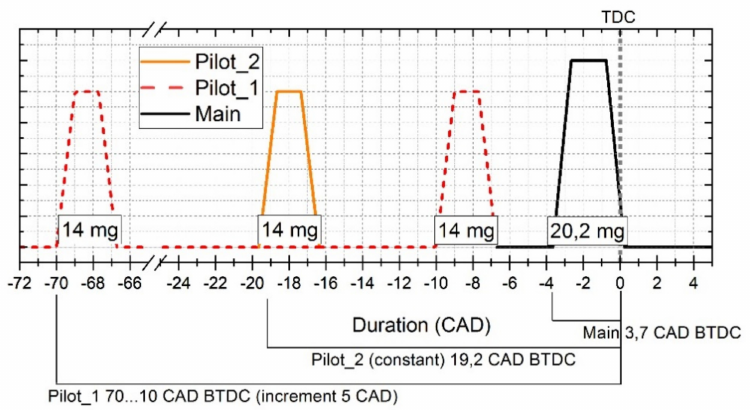
Figure 5. The injection strategy for the second pilot SOI 19.2 CAD BTDC.